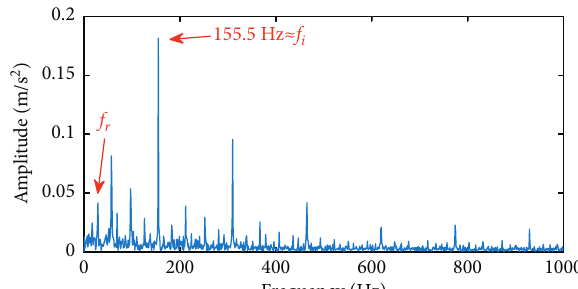
Figure 10: The envelope spectrum for the reconstructed signal of inner ring fault.